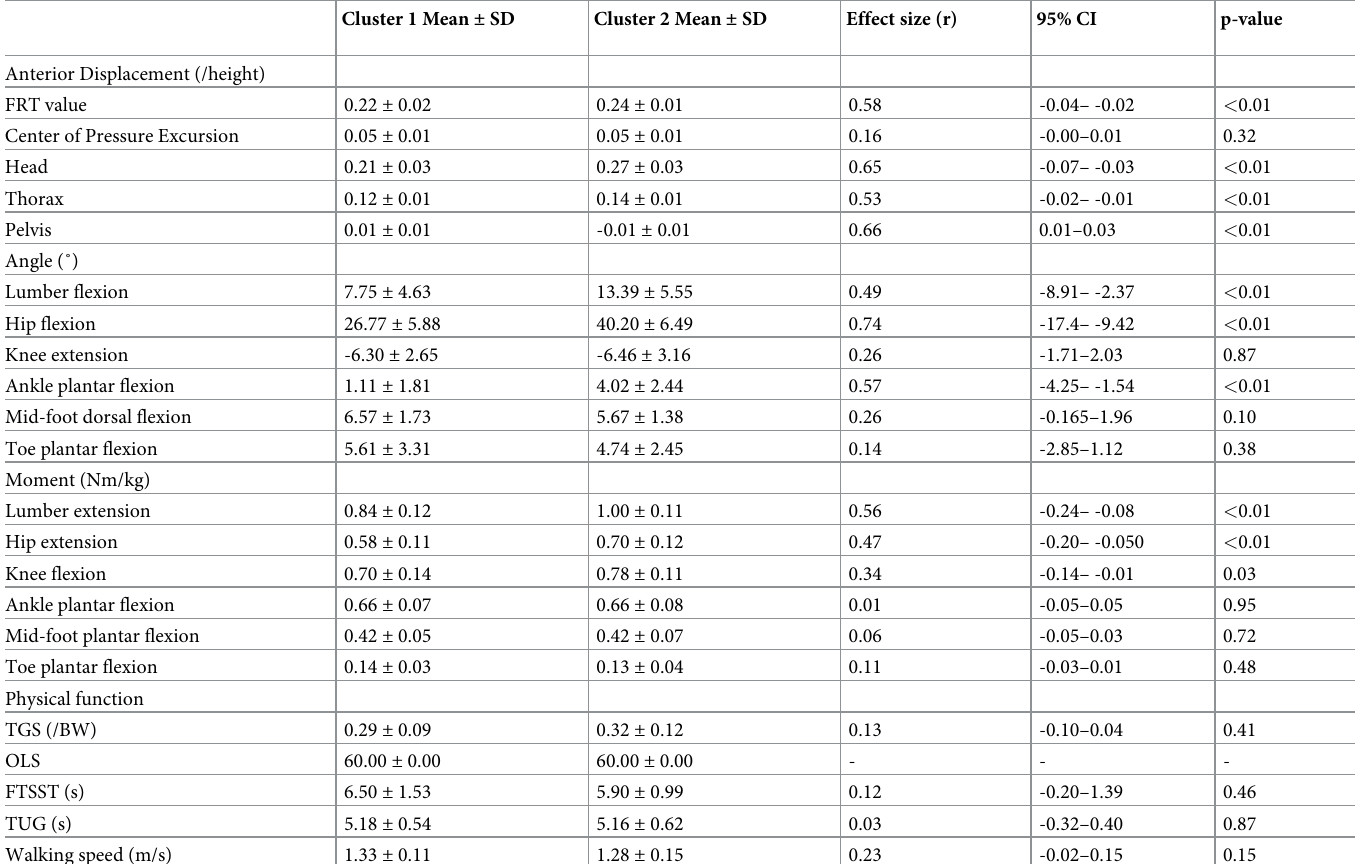
Table 1. Comparison of Cluster 1 and Cluster 2 in young